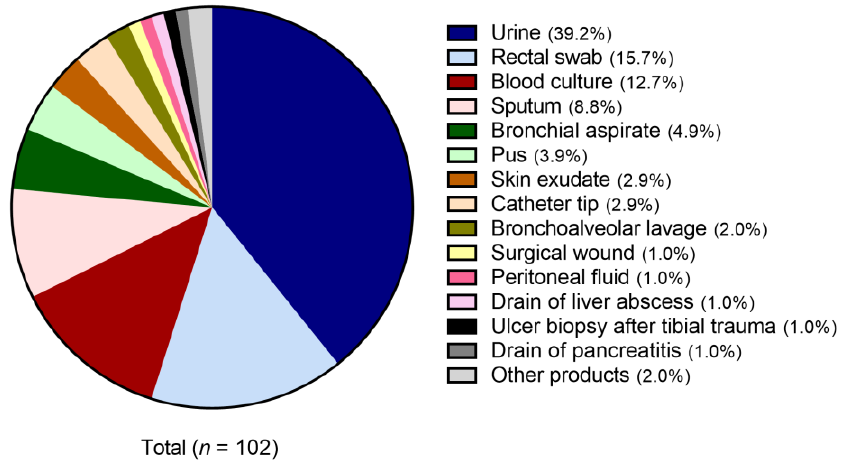
Figure 1. Distribution of Klebsiella pneumoniae isolates according to the source isolation sample.